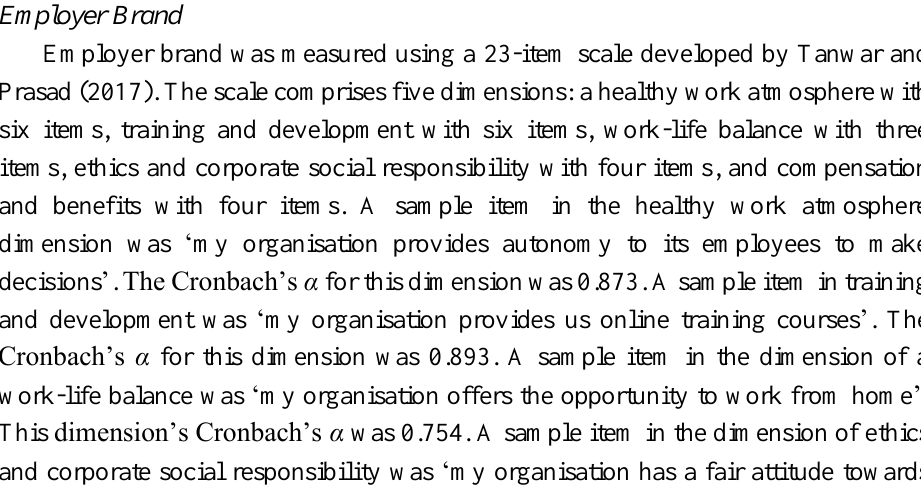
Figure 1: Conceptual Framework of the Study